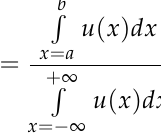
Figure 2. Membership function u ( x ).